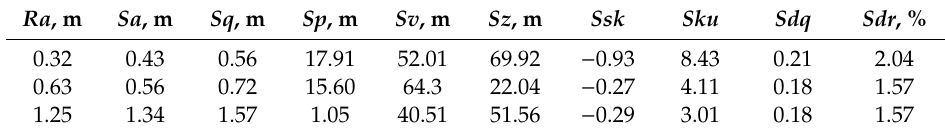
Table 4. Selected surface roughness parameters of countersample with radius R = 200 mm. Sa , m